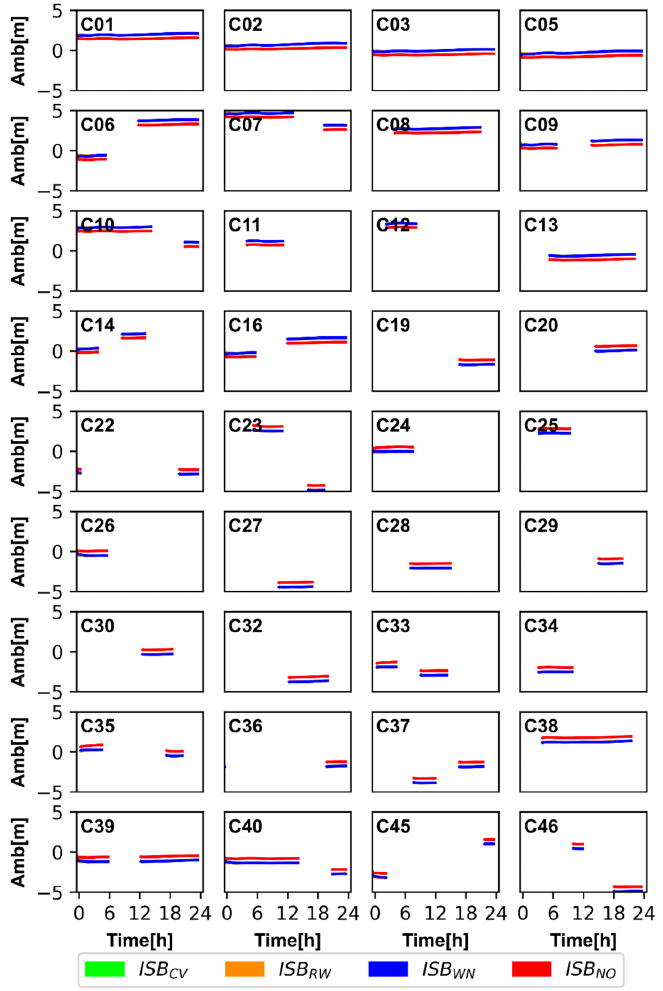
Figure 11. The ambiguities of BDS-2 (B1I/B3I) and BDS-3 (B1I/B3I) satellites for the four ISB stochastic models based on GFZ products at XIA1 station.